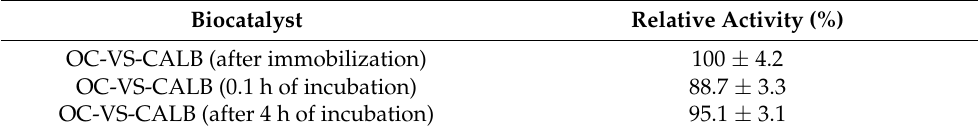
Table 1. Effect of incubation time (0–4 h) at pH 8 and 25 ◦ C on the activity of OC-VS-CALB